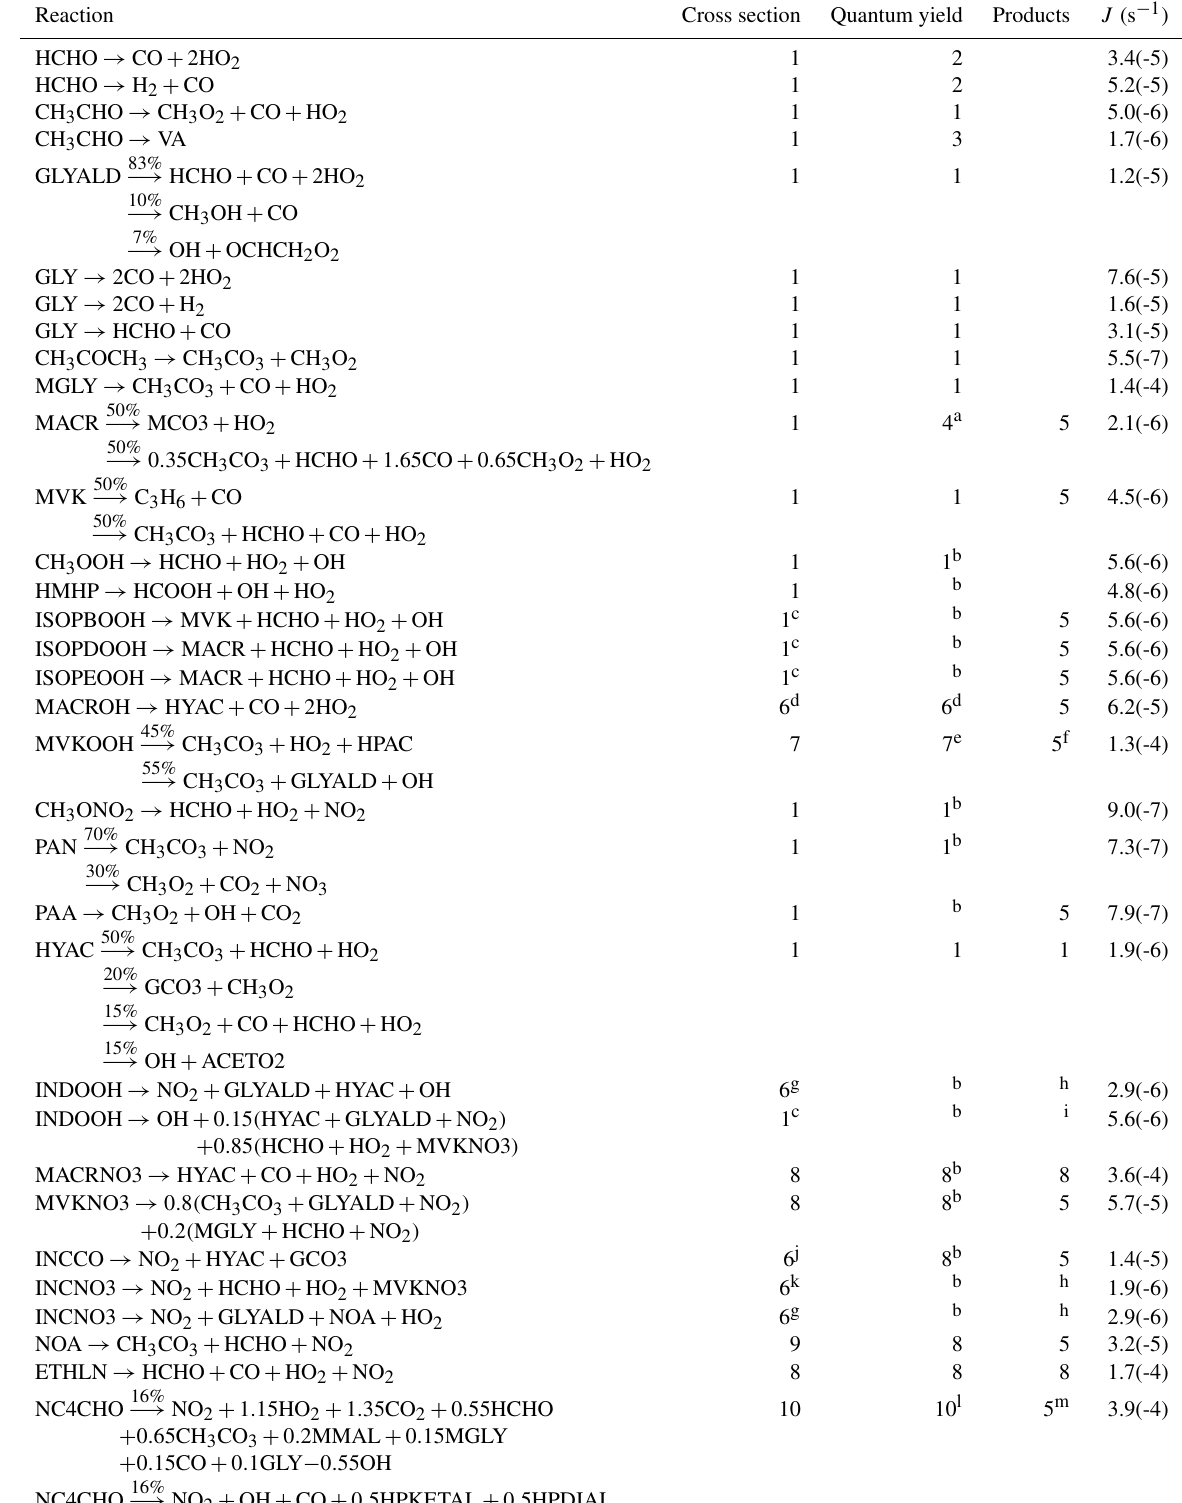
Table 3. Photodissociation reactions. The last column gives the photolysis rate ( J ) calculated using the TUV model (Madronich, 1993) for a zenith angle of 30 ◦ and 300DU ozone. References: 1, Burkholder et al. (2015); 2, Röth and Ehhalt (2015); 3, Shaw et al. (2018); 4, Pinho et al. (2005); 5, Jenkin et al. (2015); 6, Atkinson et al. (2006); 7, Liu et al. (2018); 8, Müller et al. (2014); 9, Barnes et al. (1993); 10, Xiong et al. (2016); 11, Liu et al. (2017); 12, Nakanishi et al. (1977); 13, Back and Yamamoto (1985). Reaction Cross